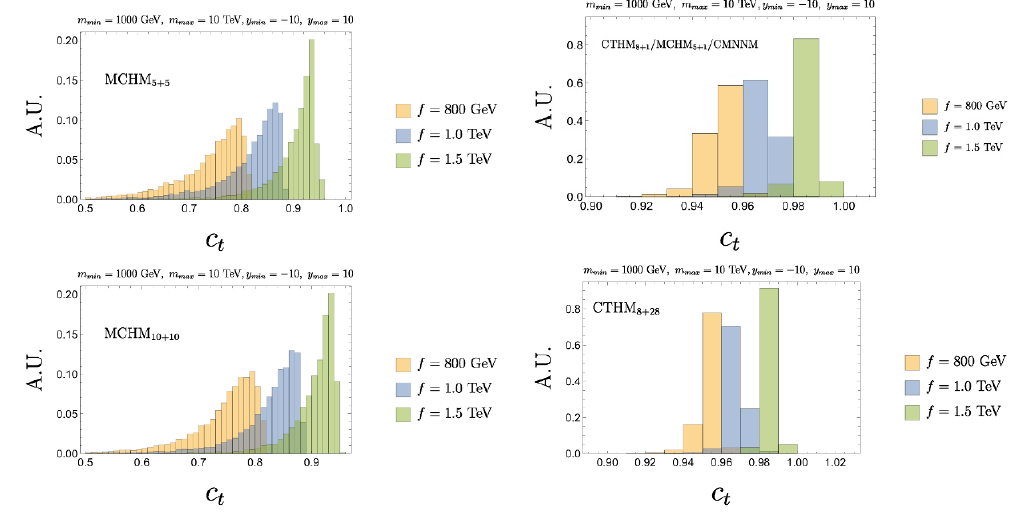
Figure 7 . The distribution of c t in the models with low dimensional representations. Di(cid:11)erent colors denote di(cid:11)erent values of (cid:24) , the width of each bin is chosen as 0 : 01, and A.U. denotes arbitrary unit.